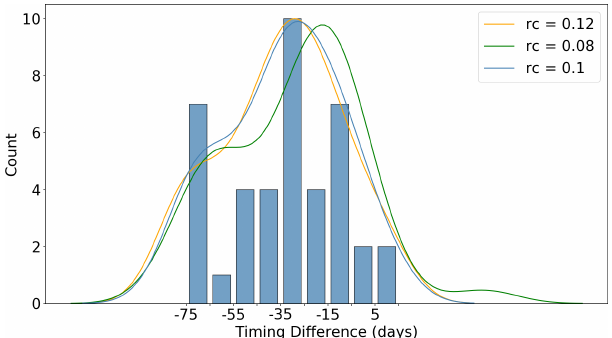
Figure 5. Distribution of the difference in timing (in days) between growth initiation (GI) and melt onset (for all floats sampling under ice). GI is defined as the point at which the time derivative of the mean mixed layer Chl a exceeds the median time derivative (com- puted for the growth period). Negative values in the distribution in- dicate that GI has occurred prior to the detected melt onset. Curved lines represent the probability density functions for several values of the assumed cooling threshold (rc) in the upper ∼ 20m of the water column. This value represents an assumed decrease in temperature over the upper ∼ 20m, which is required to delineate under ice from open ocean profiles (since floats do not sample the upper ∼ 20m in winter, they do not sample water below the freezing point). Refer to Sect. 2.2 for a discussion of the methodology used to produce the figure.